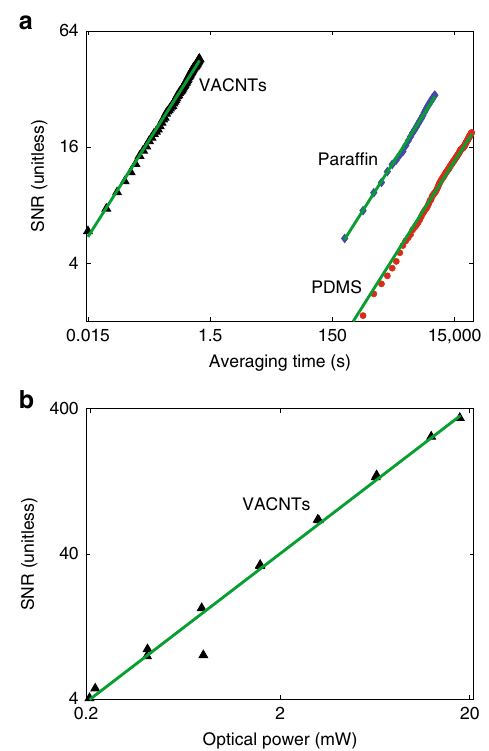
Fig. 5 Signal-to-noise ratio (SNR) of dual-comb photoacoustic spectroscopy. a Time-domain SNR of the PA signal as a function of averaging time for the VACNTs at an incident optical power of 18 mW (black triangles), paraf fi n at an incident power of 24 mW (blue diamonds), and PDMS at an incident power of 24 mW (red circles). The solid green ffiffiffi p τ lines are fi ts to the data according to SNR ¼ A ´ , where τ is the averaging time and A is a fi t parameter. b Time-domain SNR of the PA signal for the VACNT target as a function of optical excitation power at a fi xed averaging time of 61 s (triangles) and a linear fi t to optical excitation power (green line). In these measurements, spectral SNRs are roughly the same as time-domain SNRs. For comparison, a time-domain SNR of 32 for paraf fi n transforms to a peak spectral SNR of 45. This scaling changes slightly depending on the spectrum. As discussed in Supplementary Note 1, the spectral SNR at optical frequency v is de fi ned as the mean magnitude of the PA response at v divided by the standard deviation of the PA response at v over many repeated